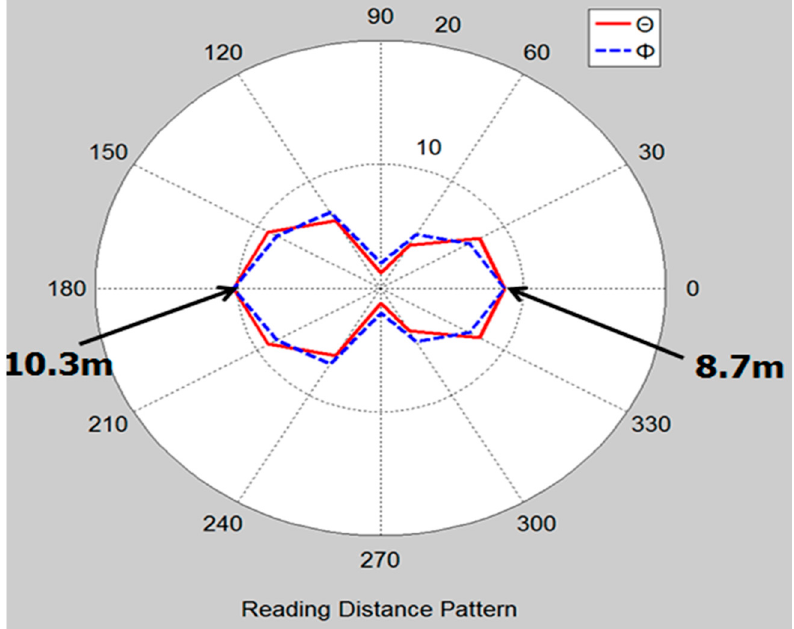
Figure 10. Measured reading range pattern with the plate holder.